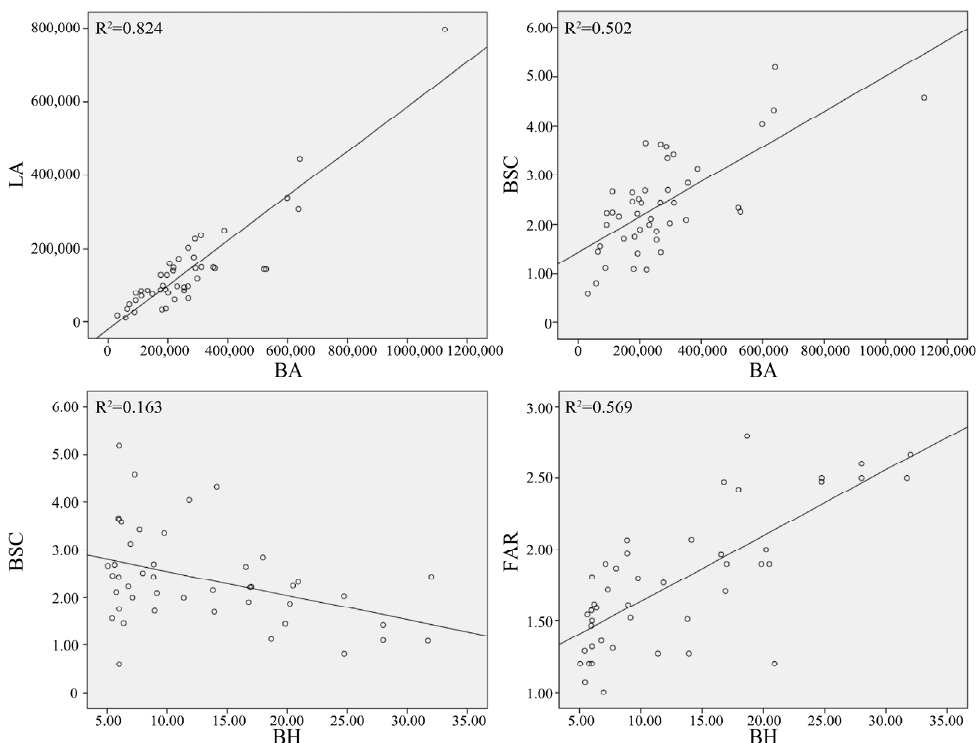
Figure 4. Relationship between BEF.